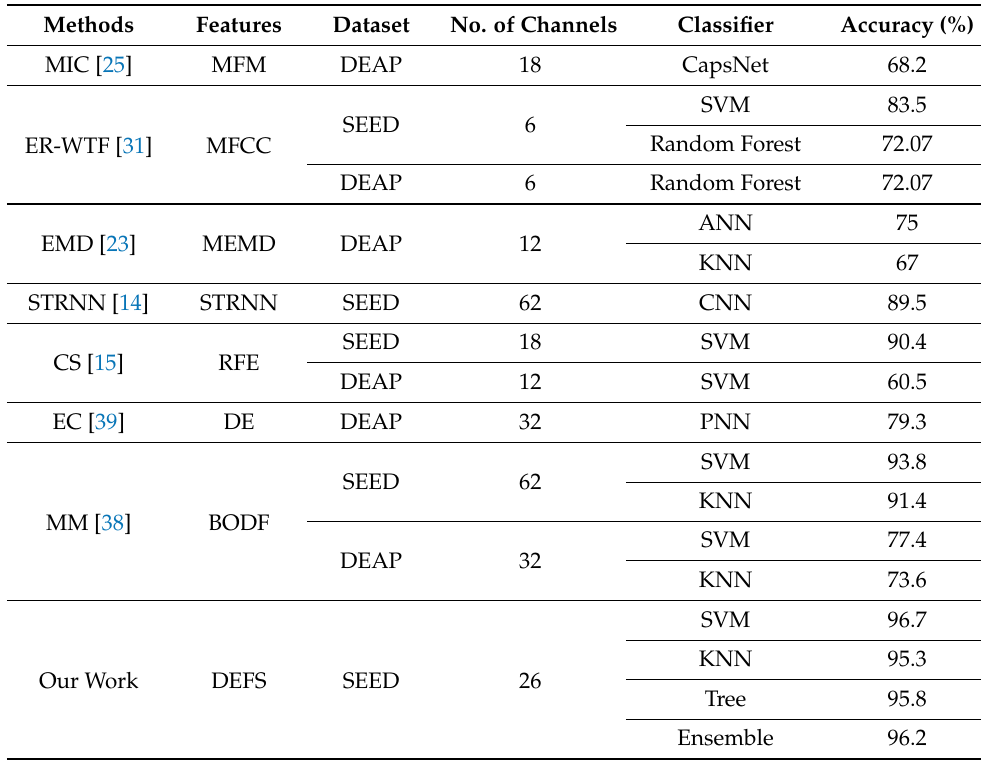
Table 4. Comparison of our proposed work with the previous work on emotion detection.